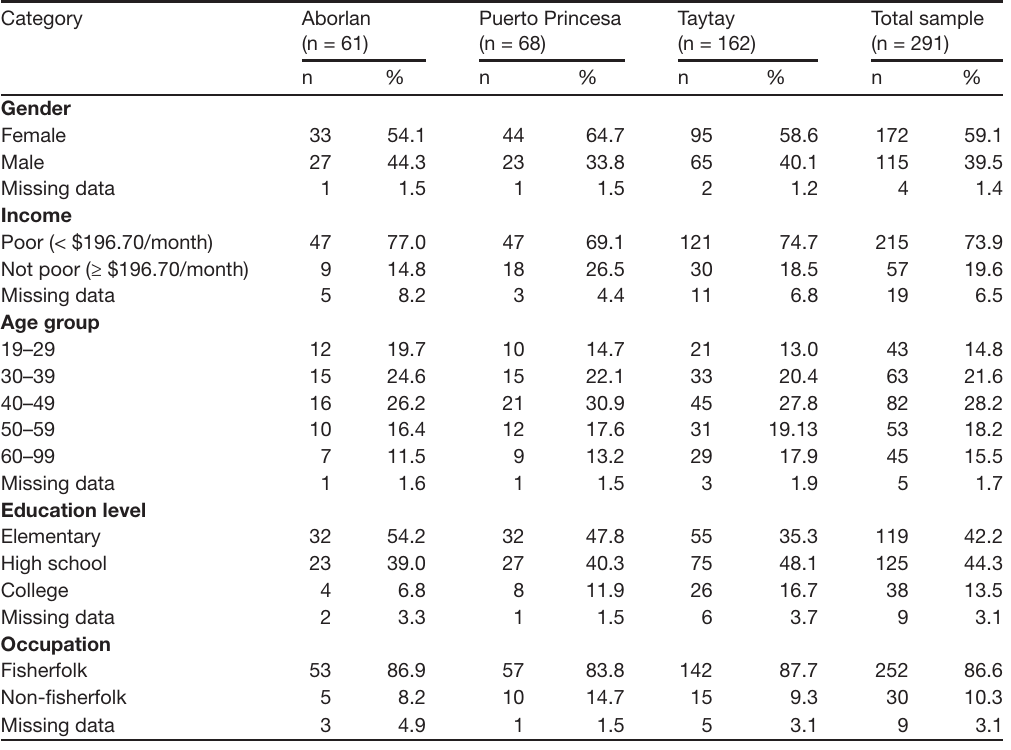
Proportion of participants who perceived that the climate in their locality is changing; climate change is a risk to the coastal marine ecosystem; and sea level rise will affect the mangrove ecosystem (n = 291). (Percentage was based on valid responses.) (Source: Authors, 2022.)